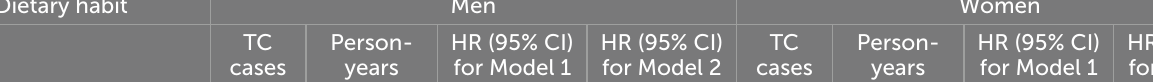
TABLE 4 Hazard ratios (HRs) and 95% confidence intervals (CIs) of incident thyroid cancer (TC) related to dietary habits by stratification of sex. Dietary habit